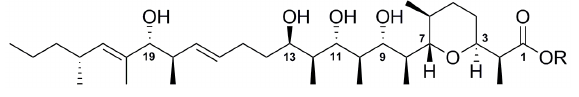
Figure 1: Structures of zincophorin (R=H) and its methyl ester